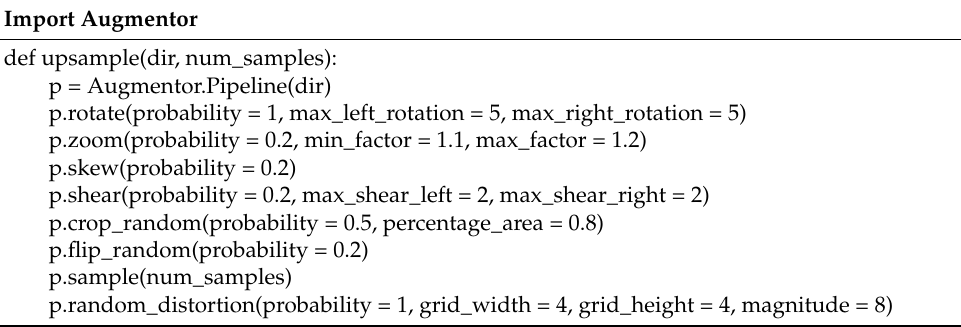
Table 4. Data augmentation Python